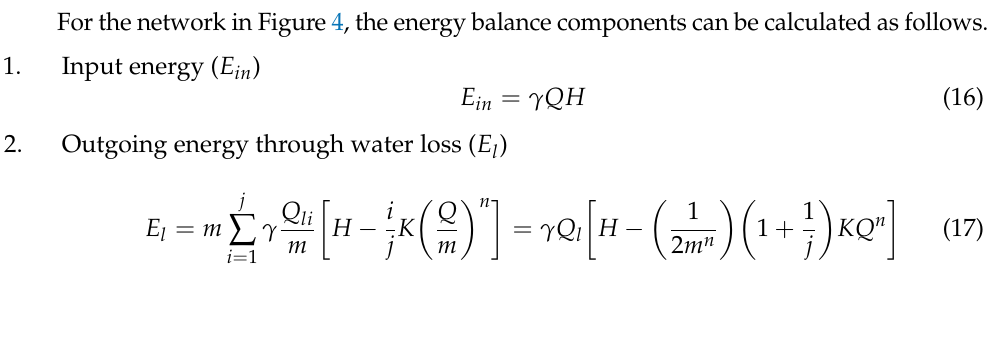
Figure 4. Energy balance for simplified branched pipe network with uniformly distributed demand nodes, where m is number of branches and j is number of demand nodes in each branch.